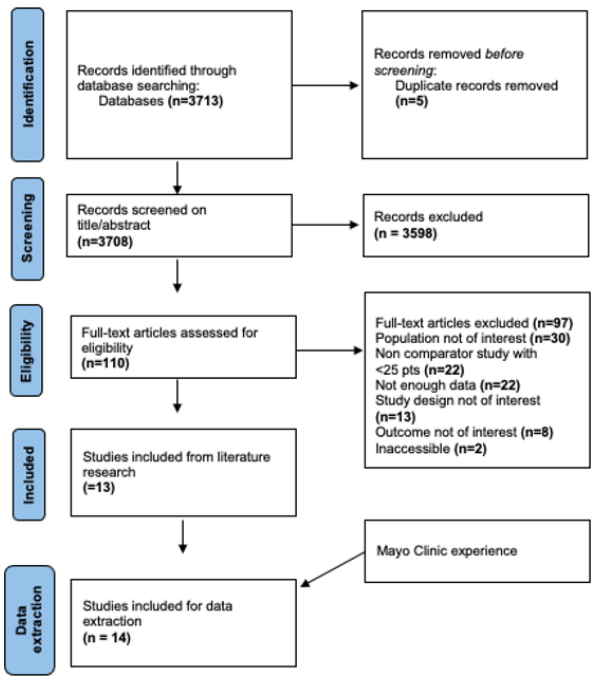
Figure 1. PRISMA flow diagram of the studies